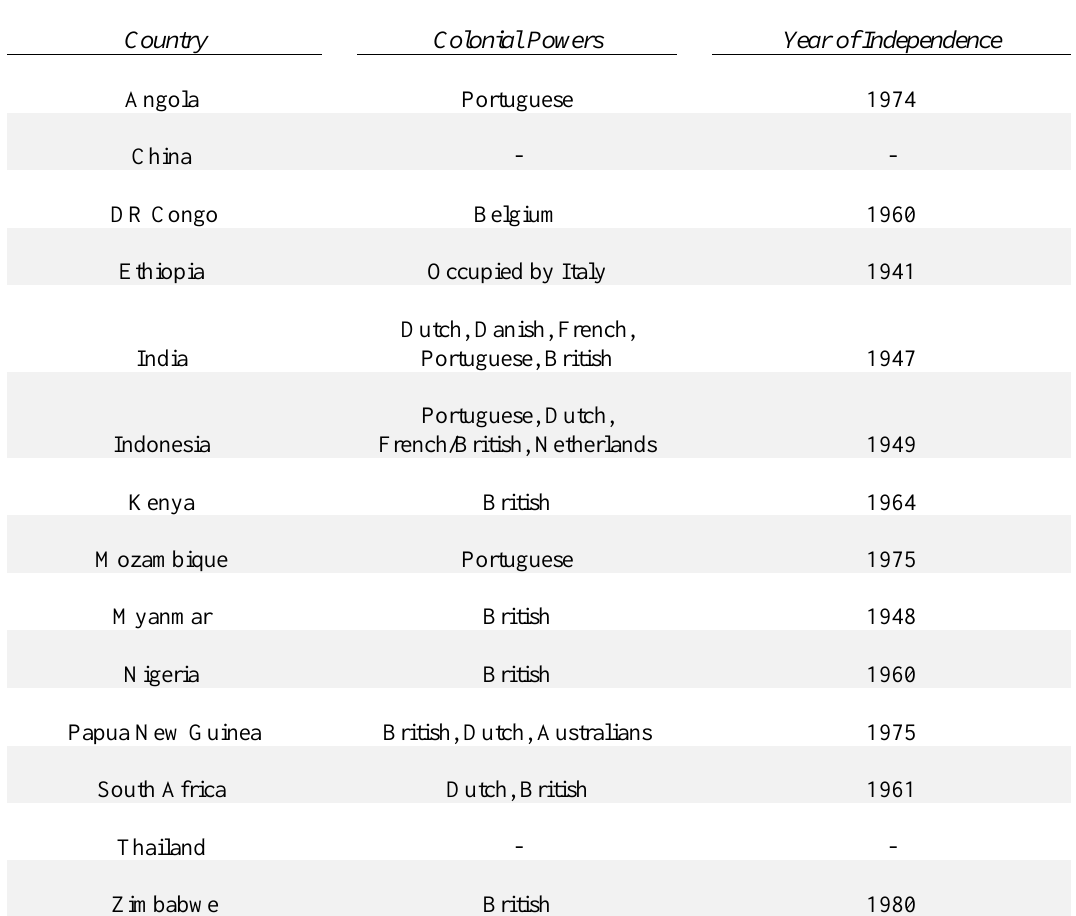
Table 2: Colonial History of High TB Burden